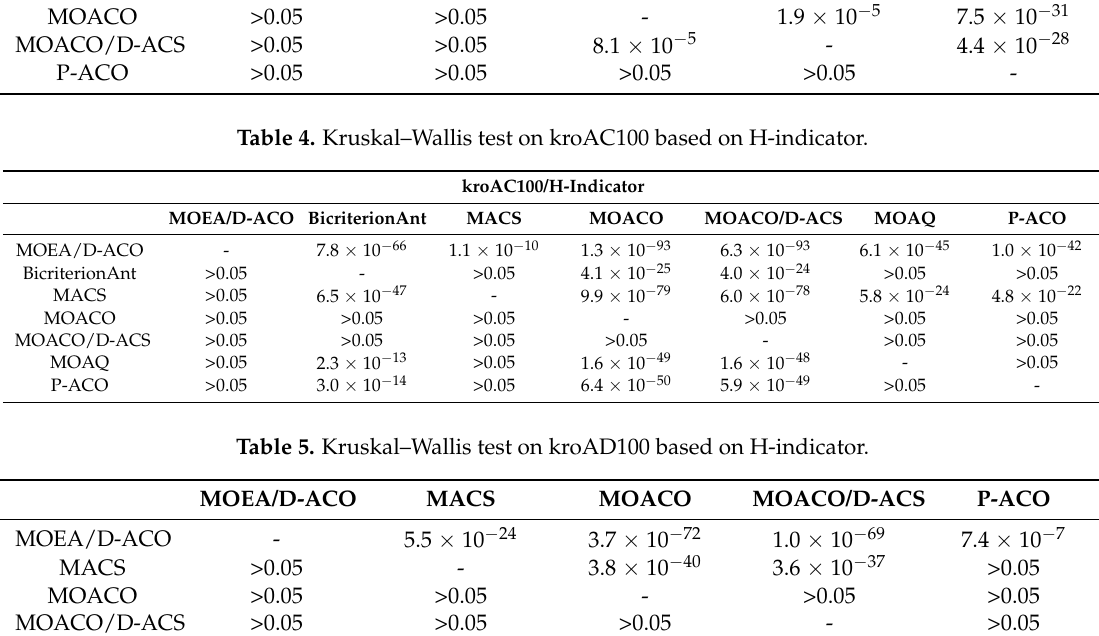
Table 4. Kruskal–Wallis test on kroAC100 based on H-indicator.